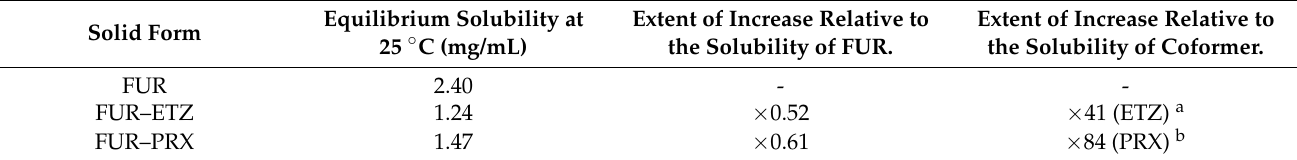
Table 4. Equilibrium solubility of FUR and its cocrystals in water PBS pH 7.4. Equilibrium Solubility at Extent of Increase Relative to Solid Form 25 ◦ C (mg/mL) the Solubility of FUR.